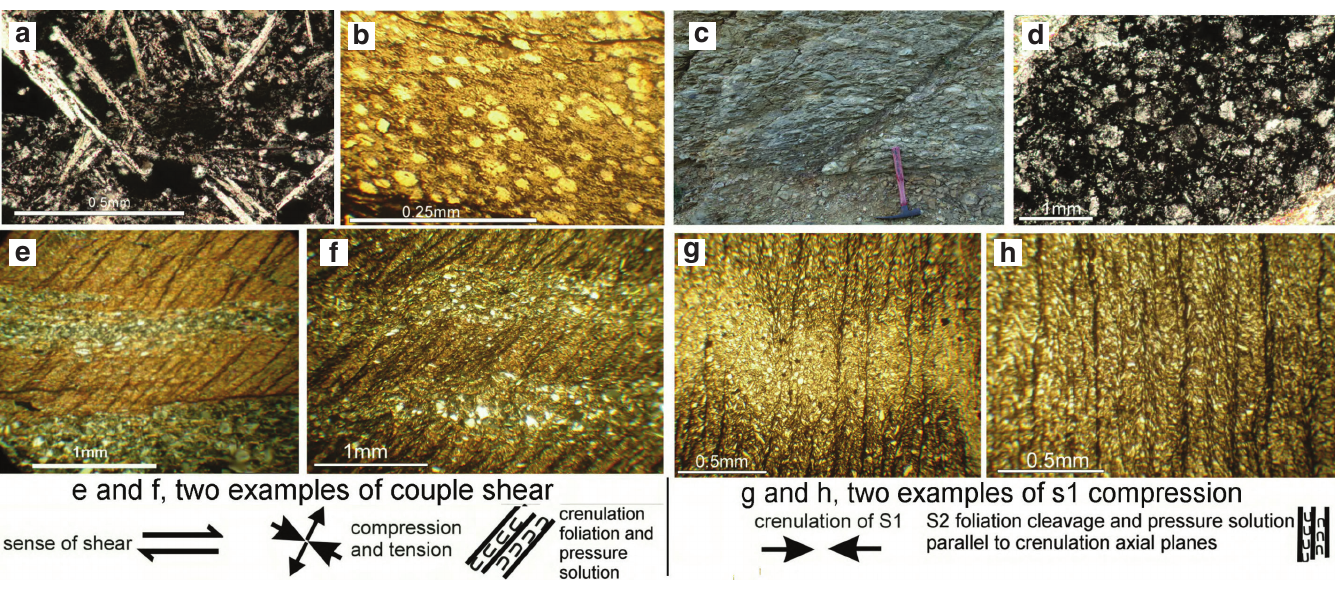
about 350°C (see Discussion below). a lithic grain of volcanic glass, inherited from the ocean floor mélange has fine, long needles, of supposed actinolite. rocks from within the brittle-ductile Foliation and rock cleavage is mainly caused by aligned mica [30, 34], or by alternating parallel shear zone. porphyroclast bands that are crossed obliquely by foliation/shear planes, which may be observed (a) photomicrographs xpl, of a basalt best under the microscope, and of which numerous examples show foliation/cleavage that has lithic grain, alonnisos. acicular plagioclase in a vesicular basalt. been crenulated by compression (Fig. 4e–h). Other examples indicate that the sericite of the (b) Photomicrograph ppl of slightly foliation plains became reoriented parallel to a secondary shear plane (Fig. 4g, h) (a phenomenon deformed radiolarian ghosts in also shown in [35]). sericitized, fine crystalline quartz, agios riginos, skopelos. (c) Foliated Polyepisodic successions, in which alternating brittle and ductile deformations had taken place, cataclasite resembling a conglomerate, agios Georgios, alonnisos, actually a have been seen in numerous thin sections from alonnisos and skopelos; typical of shear zones fault rock of the shear zone composed according to higgins [25]. Likewise, observations of complex overprinted brittle and ductile of porphyroclasts aligned parallel to structures were reported in Meyer et al. [36]. similar brittle-ductile deformations have been reported the (+/− horizontal) composite s–C foliation. secondary shear planes appear to have formed at an angle of about 45° with the composite foliation (s1). (d) Photomicrograph (xpl). This fluxion-structured band of quartz Maddock [26] and higgins [25] (compare also [36]). The supposed pseudotachylite of the study clasts in opaque/isotropic? matter is area occurs as millimetre thin, braided sheets of opaque matter, laden with quartz porphyroclasts, interpreted as pseudotachylite. The which alternate with fluxion structured, aligned sericite, imbedded in interstitial, finer grained matrix, fluxtion-band is bordered by sericite (upper left, lower right). Quartz appears which intrudes adjacent fractures. The quartz grains of the fluxion sheets are serrated, giving the to be disintegrating along the margins, appearance of having been melted on their edges and then frozen in a once fluid medium (Fig. 4d). frozen in a flood of opaque matter. Pseudotachylite is not uncommon in tectonic thrust and subduction zones from the alps to alaska (e–f) Photomicrographs ppl, foliated phyllonite. These two examples of [26, 31, 38, 39]. higher grade metamorphic minerals other than greenschist facies have not been shearing-couples show the sense of observed. according to Porkoláb et al. [28] temperatures between 350 and 450°C in the pressure shear and the crenulation-solution range 1–2 GPa, prevailed during shearing. cleavage that formed perpendicular to the compressional-stress component of the shearing couple (examples are described in [34]). (g–h) Photomicrographs ppl, foliated phyllonite. These two examples show development of a new schistosity via a crenulation cleavage (stage 4 in [35]). Examples e–h involve neomineralisation and recrystallisation of